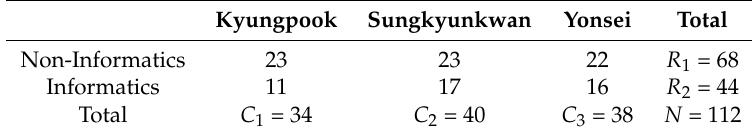
Table 3. The result of Fisher’s exact test using universities and courses. Kyungpook Sungkyunkwan Yonsei Total Non-Informatics 23 23 22 R 1 = 68